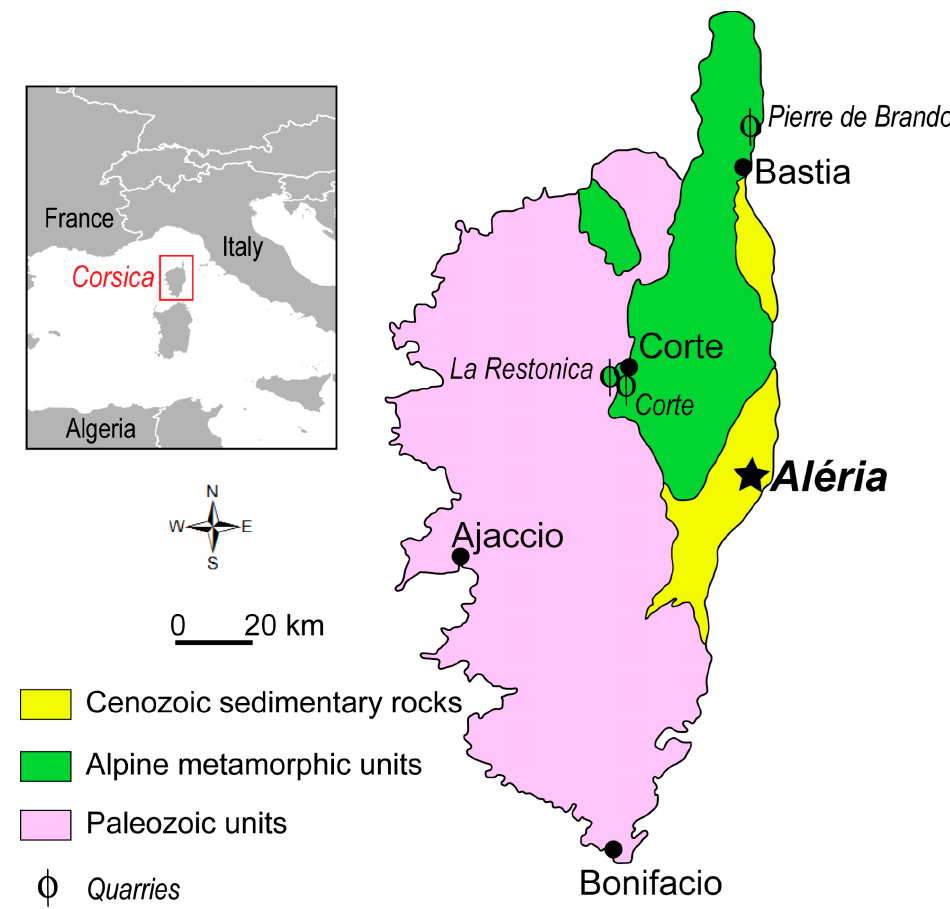
Figure 1. Simplified geological map of Corsica (modified after